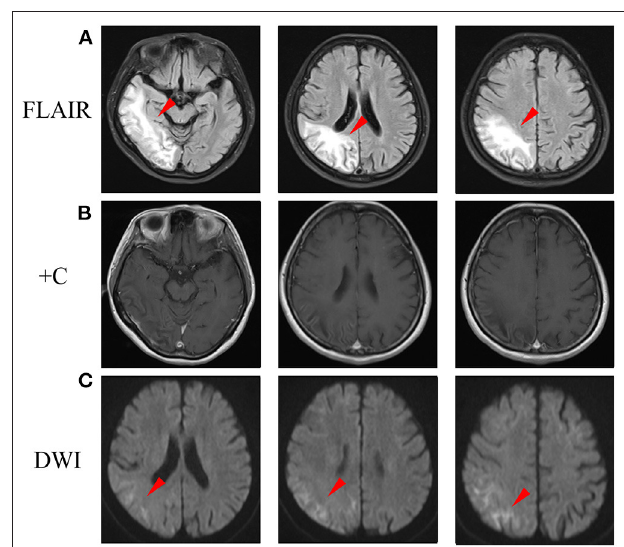
FIGURE 3 | A follow-up brain MRI performed 3 months later after disease onset. (A) FLAIR images showed abnormal hyperintensity was improved in cortex, while progressed in the subcortical area (arrowheads). (B) Post-contrast MRI showed cortical enhancement was reduced. (C) DWI showed hyperintensity in the corticomedullary junction progressed (arrowheads). DWI, diffusion-weighted image; FLAIR, fluid-attenuated inversion